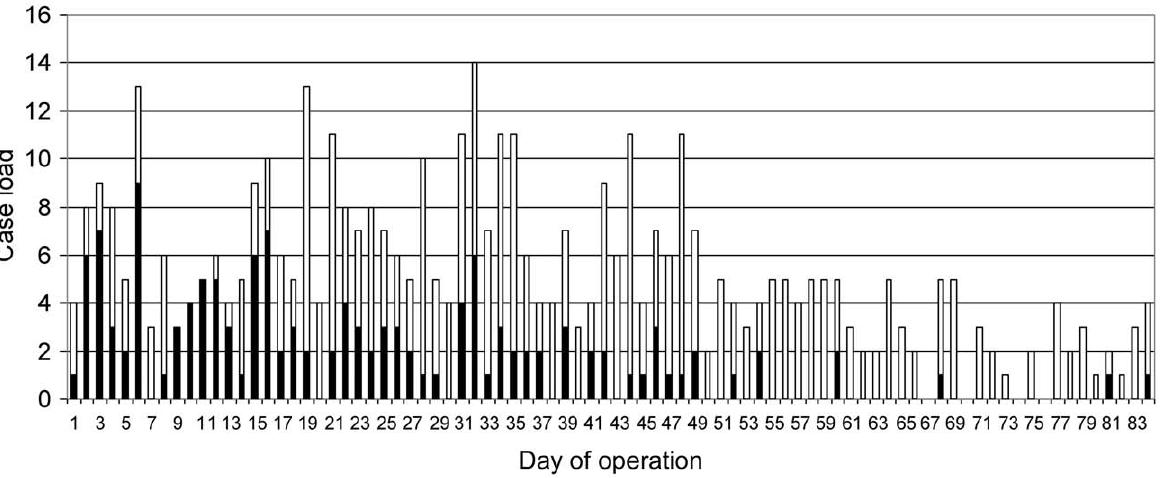
Figure 3. Field MARV diagnostic lab at Uige, Angola 2005; daily case load and positive sample detection. The height of each bar represents the total daily case load for the lab with the positive cases indicated by the solid portion.